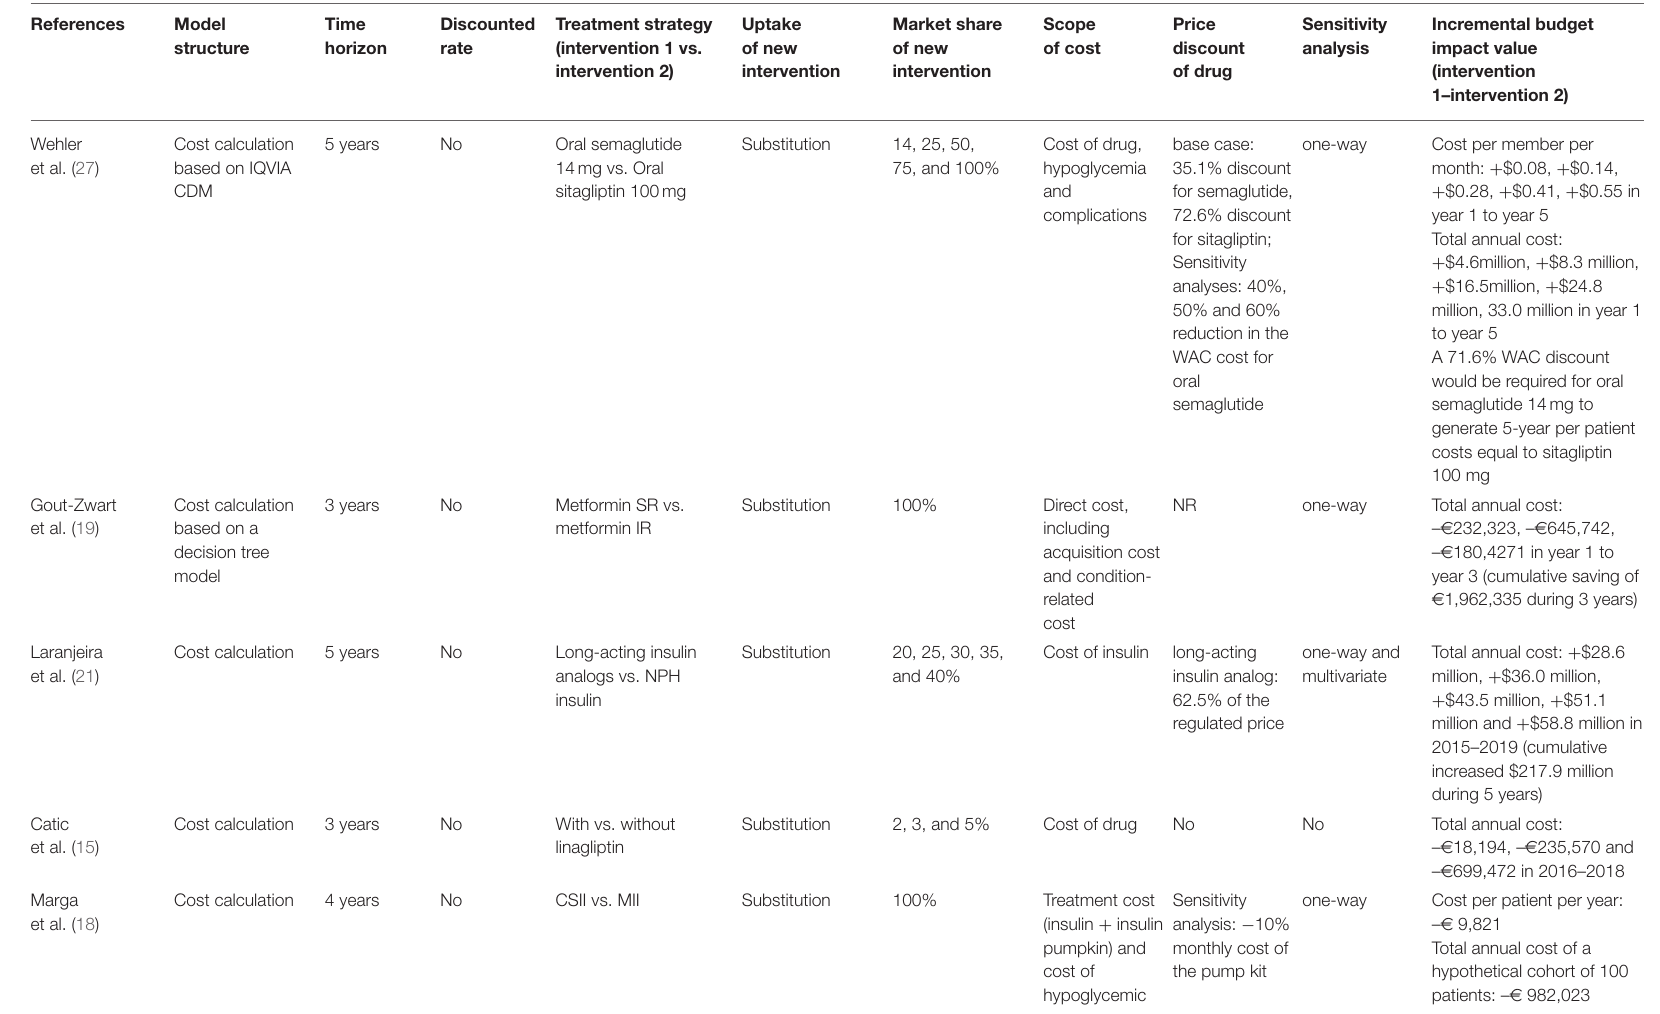
TABLE 2 | Methodology and budget results of